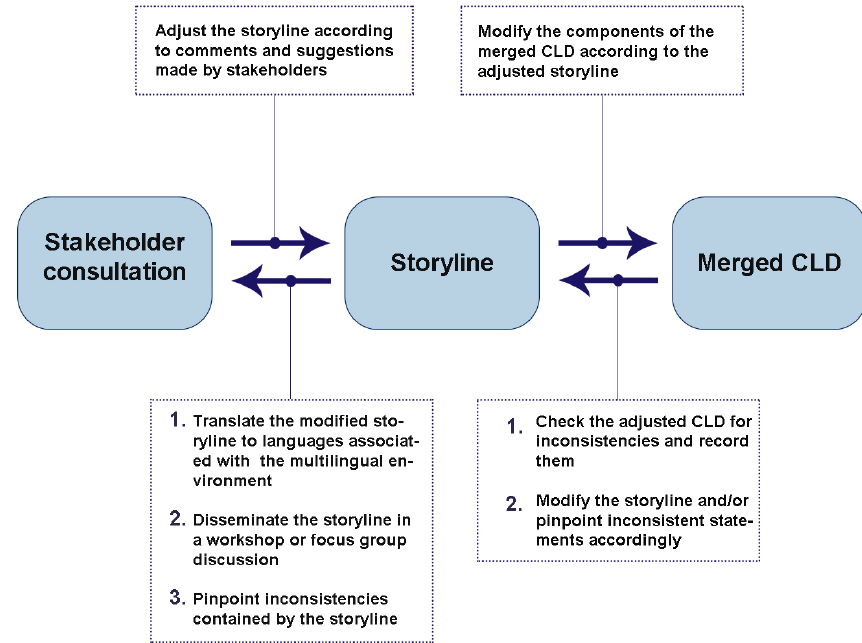
Figure 6. Iterative process between stakeholder consultation, storyline development, and CLD